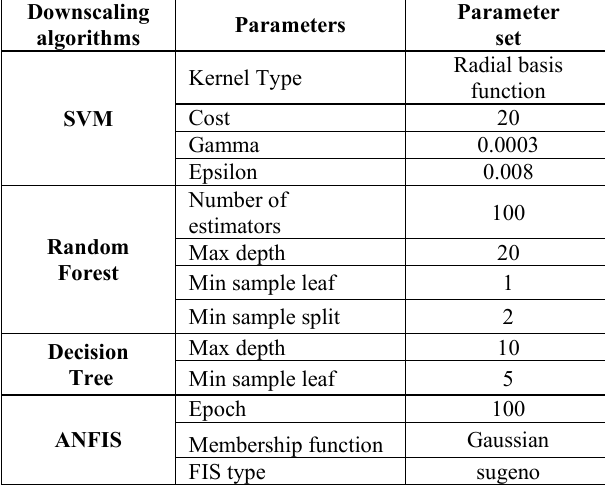
Table.2 Parameters setting for machine learning methods-based downscaling